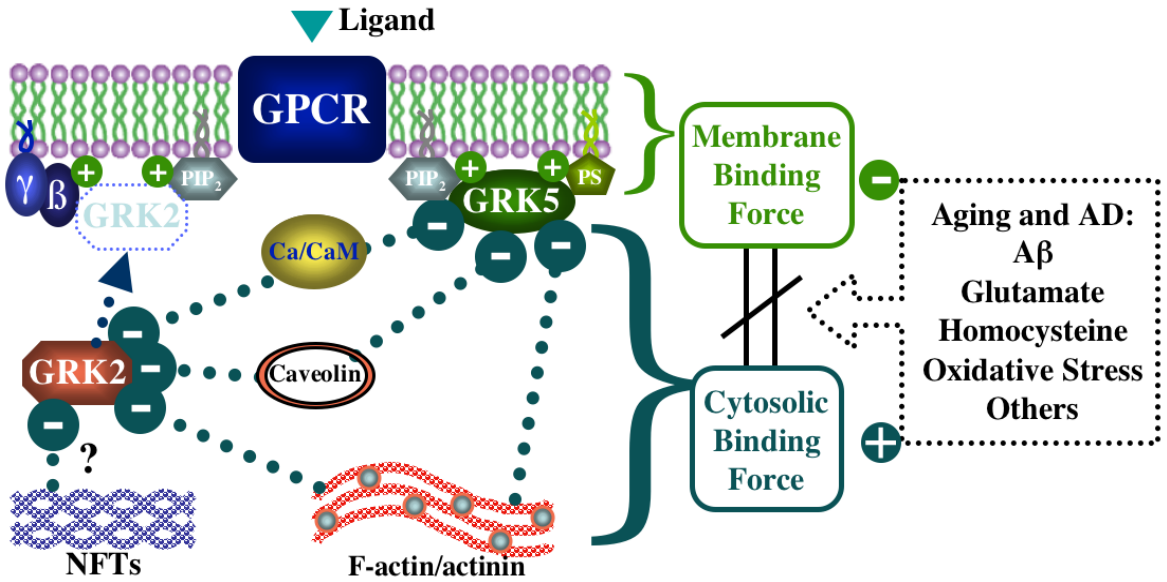
FIGURE 1. Regulations of GRK subcellular locations. Balance between membrane (i.e., PIP2 and G βγ subunits for GRK2, and PIP2 and PS for GRK5) and cytosolic (i.e., calcium sensor proteins, caveolin, and stress fibers) binding forces determines the subcellular locations of GRKs, whereas aging- and AD-related factors may break the balance and push it towards cytosol. Ca/CaM stands for Ca 2+